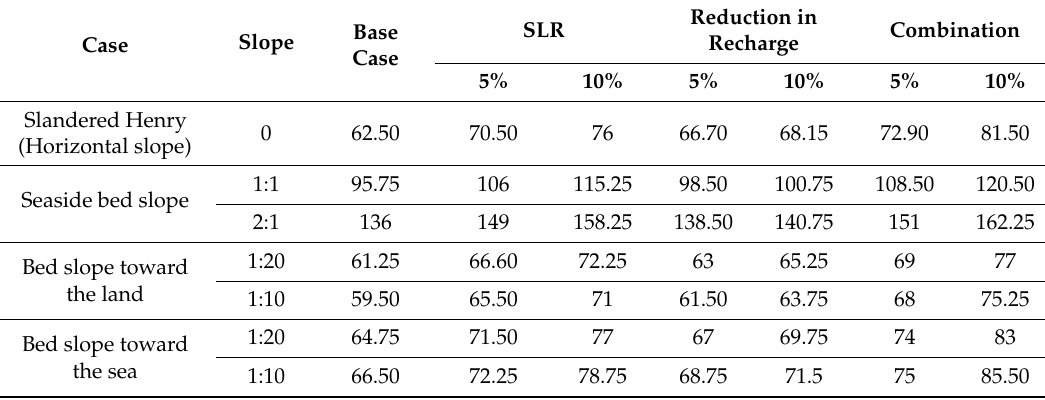
Figure 13. Relationship between intrusion length (X T ) and SLR for different slopes. Table 2. The intrusion length (X T ) for different cases.